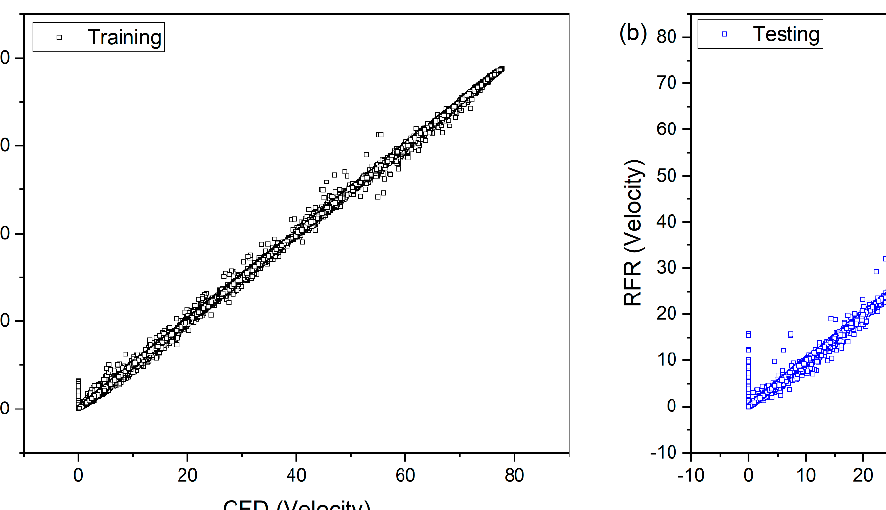
Figure 4. Correlation heat map between features and